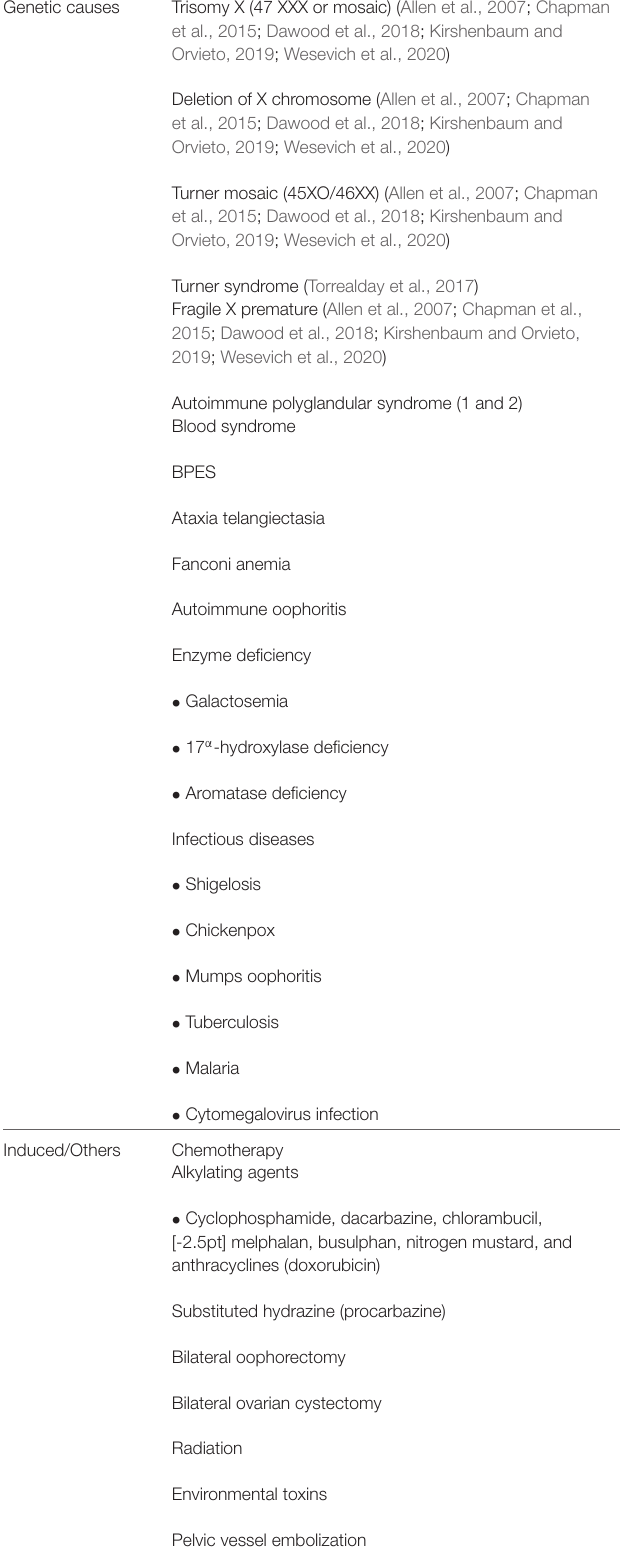
TABLE 1 | Causes of premature ovarian insufficiency (POI). Genetic causes Trisomy X (47 XXX or mosaic) (Allen et al., 2007; Chapman et al., 2015; Dawood et al., 2018; Kirshenbaum and Orvieto, 2019; Wesevich et al.,